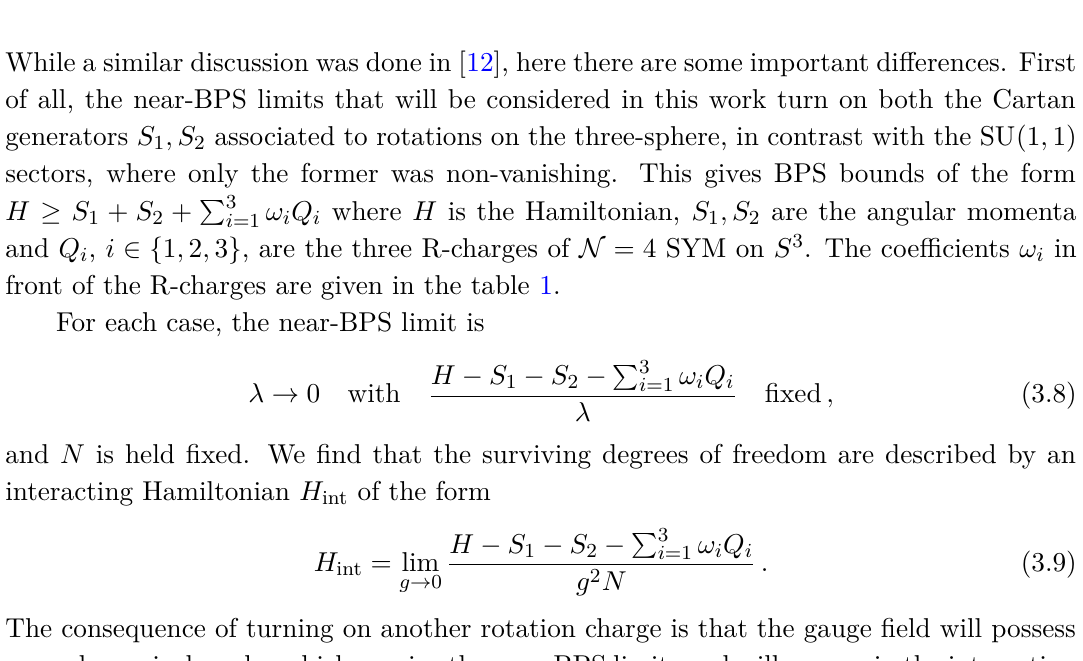
+ S + P 3 ω i Q i 1 2 i =1